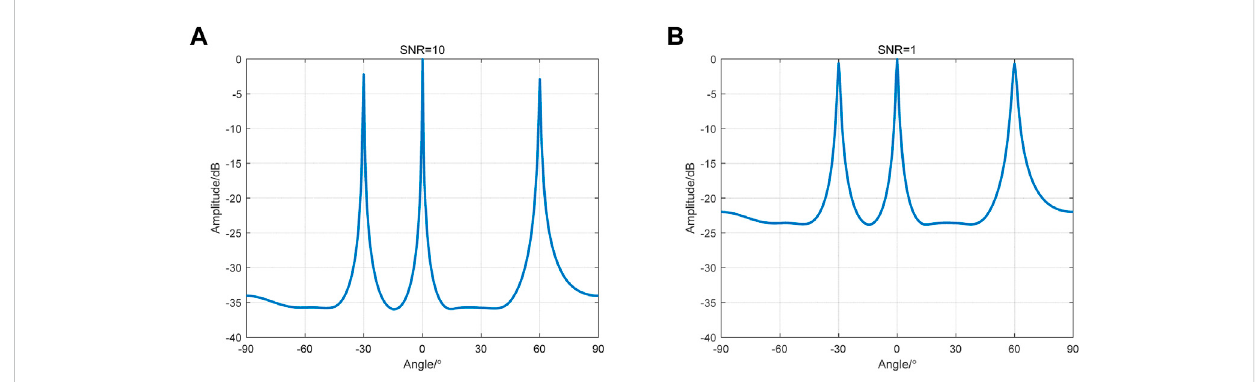
FIGURE 5 SimulationresultsoftheMUSICalgorithm. (A) Theresultofdirection fi ndingwhentheSNRis10. (B) Theresultofdirection fi